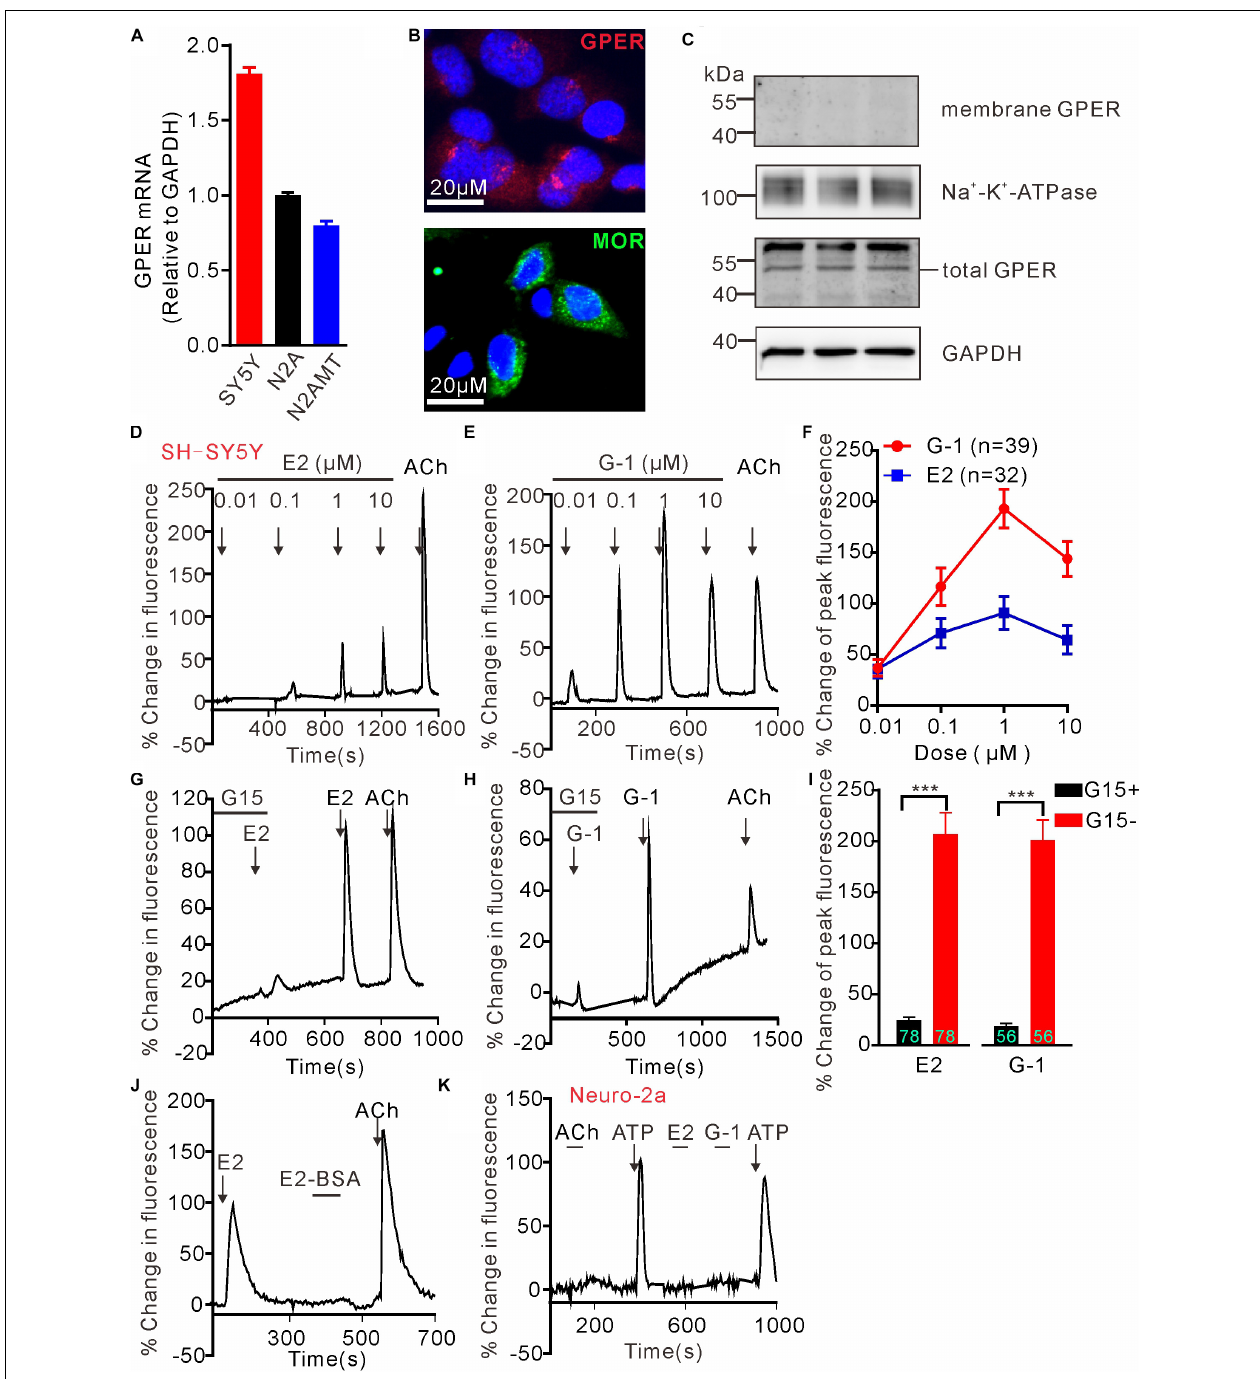
FIGURE 1 | G protein-coupled estrogen receptor mediates calcium rise in SH-SY5Y cells. (A) RT-PCR analysis shows relatively higher expression of GPER mRNA in SH-SY5Y cells than in Neuro-2a (N2A) cells. N2AMT is a line of Neuro-2a stably expressing human µ type opioid receptor (hMOR). (B) Immunofluorescent staining for GPER and MOR in SH-SY5Y cells. GPER immunofluorescence is located at certain perinuclear organelle. (C) Western blot detection of GPER in cytoplasmic membrane fraction vs. total protein. Whereas GPER immunoreactivity is abundant in the total protein samples, it could not be detected within the cytoplasmic membrane protein sample. (D–J) Fluo-4-based imaging of cytosolic [Ca 2 + ] transients in response to GPER agonists 17- β estradiol (E2) and G-1. Note E2 and G-1 both caused concentration-dependent rapid Ca 2 + rise, which was prevented by GPER antagonist G15. The membrane impermeable BSA-conjugated E2 was unable to evoke a rapid Ca 2 + rise. (K) Neither E2 nor G-1 was able to cause a Ca 2 + rise in N2A cells. The example traces (D , E , G , H , J , K) are the average percentage change in fluorescence of 7–26 cells in one visual field. Values in bar graphs (F , I) are averaged peak percentage changes of 32 ∼ 78 cells from three to four independent tests. Note that the responses to the lowest concentration (0.01 µ M) of E2 or G-1 in separate experiments were quite variable (e.g., D,E ), but on average the peak response to E2 or G-1 (0.01 µ M) were similar (F) . ∗∗∗ P < 0.001, paired t -test.